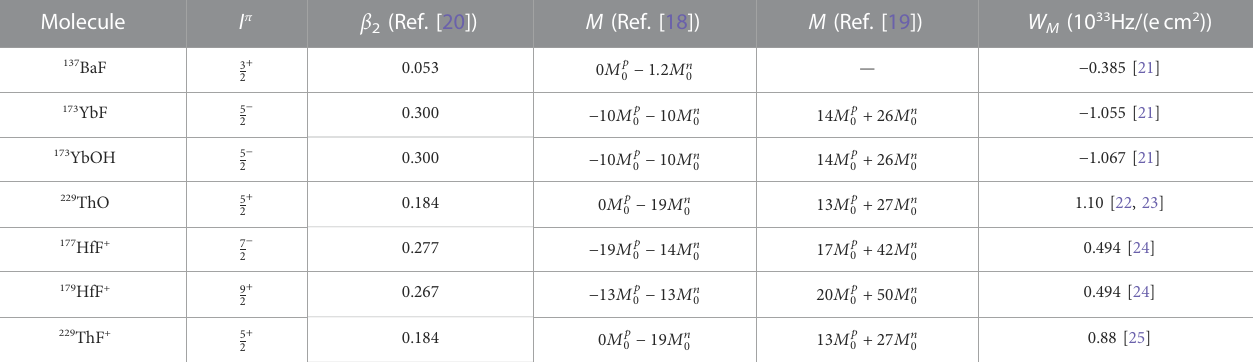
TABLE 1Properties of certain molecules relevant for a nuclearMQMmeasurement. The selected molecules are ones currently being used or explored for electron EDM measurements. The P,T-violating energy shift due to a nuclear MQM, M , is proportional to W M M , where W M is the interaction strength. We list the nuclear spin, parity, quadrupole deformation ( β 2 ), M, and W M . The collective enhancement of M due to the deformation of the nucleus was calculated in [18, 19] using different nuclear orbitals, and expressed in terms of the single-nucleon contributions to the MQM, M p / n 0 . Molecule I